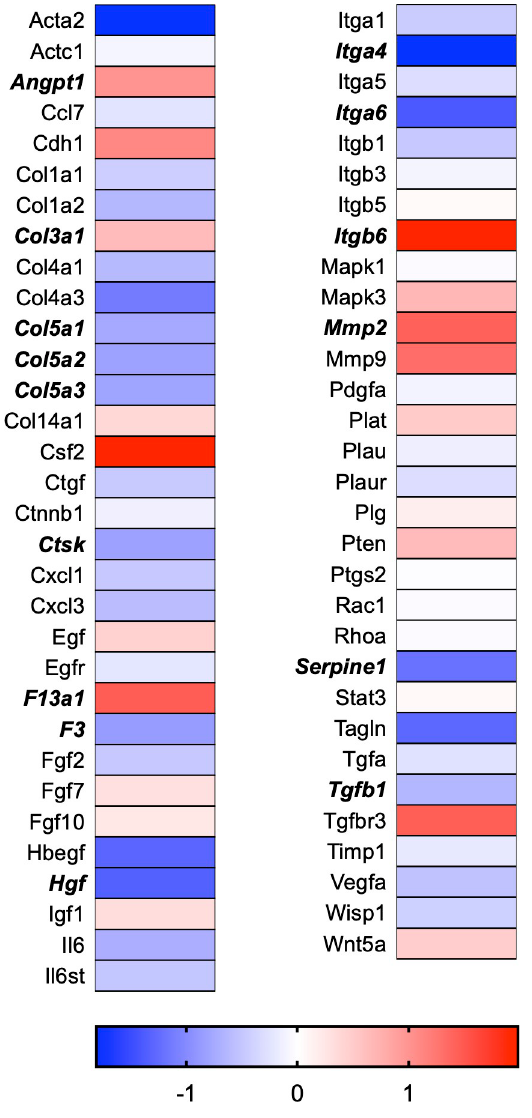
Fig 10. Wound healing heat map. Bold text indicates significantly altered gene